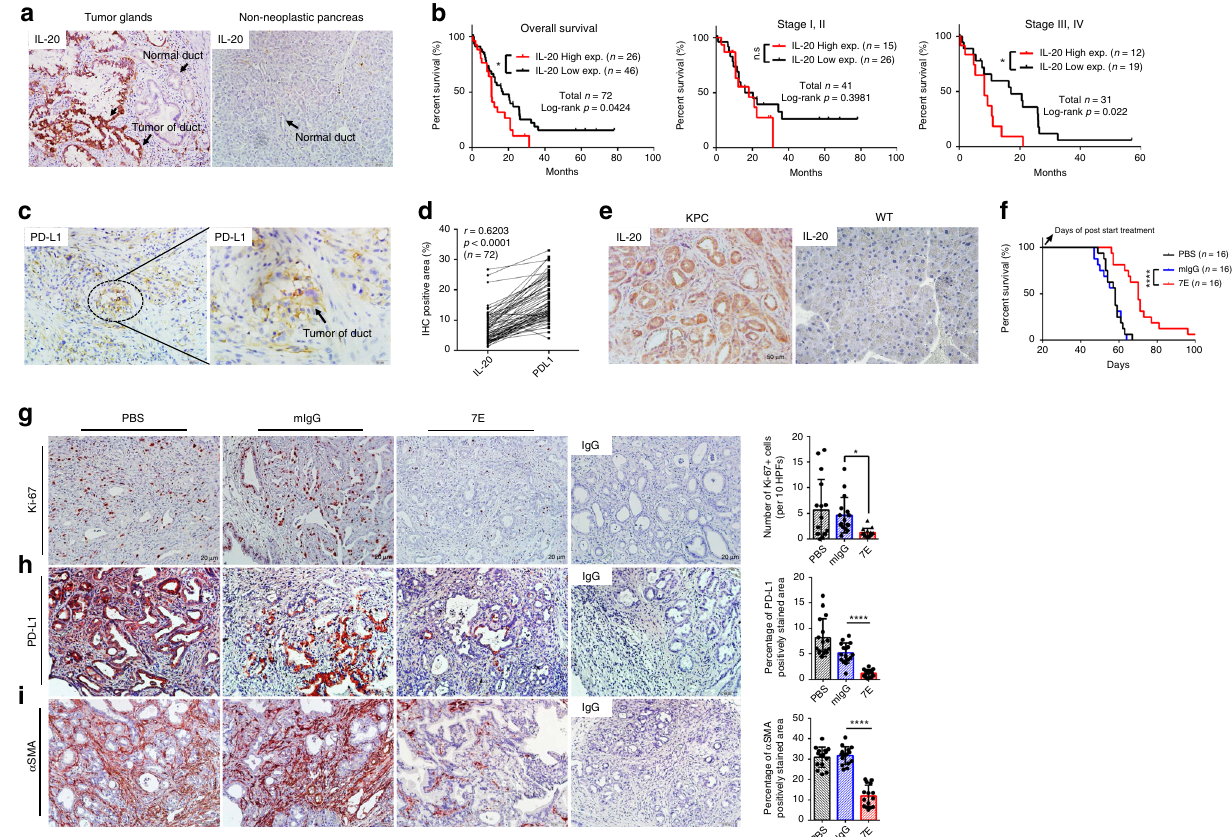
Fig. 1 Poor clinical outcomes in pancreatic cancer were associated with high IL-20 expression in patients and targeting IL-20 prolonged survival and inhibited PD-L1 and α SMA expression in KPC mice. The expression of IL-20 or PD-L1 was analyzed in 72 clinical tissue samples by using immunohistochemical staining. a IL-20 staining was positive in tumor cells and neoplastic ductal epithelial cells in pancreatic tumors but negative in normal ducts (left panel). IL-20 staining was not visible in nonneoplastic ducts (right panel). Scale bar, 50 μ m. b Kaplan – Meier analysis of the overall (left panel; n = 72 patients), early-stage (middle panel; n = 41 patients), and late-stage (right panel; n = 31 patients) survival of patients with PDAC with different levels of IL-20 expression was performed. p values, two-sided log-rank test. c PD-L1 staining was visible in the tumor tissue of a patient with PDAC, and the right image shows the enlarged area. Original magni fi cation for images: ×200; scale bar, 50 μ m; enlarged area: ×400, scale bar, 20 μ m. d The expression of both IL-20 and PD-L1 was analyzed in PDAC tumors ( n = 72 patients). Representative images of IL-20 and PD-L1 were analyzed by using the Tissue-Faxs software for IHC quanti fi cation and Pearson coef fi cients for the correlation between IL-20 and PD-L1. p < 0.0001. e IHC staining for IL-20 in pancreases from KPC and WT mice was performed. Original magni fi cation: ×200; scale bar, 50 μ m. f Kaplan – Meier survival analysis showed prolonged survival in 7E- treated KPC mice ( n = 16). **** p < 0.0001 compared with mIgG-treated controls. g IHC analysis and quanti fi cation were performed for Ki-67 + proliferating cells in the pancreas of KPC mice treated with PBS, mIgG, or 7E (each group, n = 16). Original magni fi cation: ×200; scale bar, 20 μ m. One-way ANOVA, p = 0.0082; * p < 0.05 compared with mIgG-treated controls. IHC staining and quanti fi cation were performed for h PD-L1 (one-way ANOVA, p < 0.0001; n = 16) and i α SMA (one-way ANOVA, p < 0.0001; n = 15) expression in tumors from KPC mice. The rightmost panels show IgG-stained negative controls.